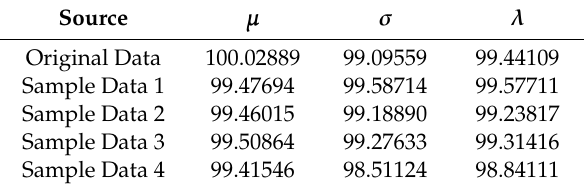
Table 3. PDA-based EEG data segmentation (original data set contains 10,000 items, sample data set 1 contains 2000 items, sample data set 2 contains 1250 items, sample data set 3 contains 1000 items, and